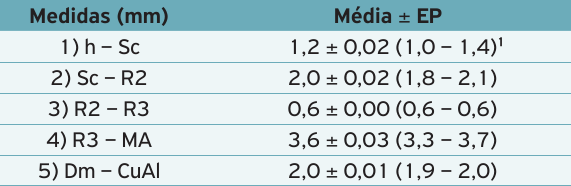
¹Intervalo de Variação. 1) da parte externa da nervura umeral (h) até nervura subcostal (Sc); 2) da nervura subcostal (Sc) até a parte externa da nervura Radial 2 (R2); 3) da nervura Radial 2 (R2) até a parte externa da Radial 3 (R3); 4) deste último ponto (R3) até a parte inferior anterior da nervura média (MA); e 5) nervura que se localiza entre a célula Dm e CuAl. (n=20); EP: erro padrão.